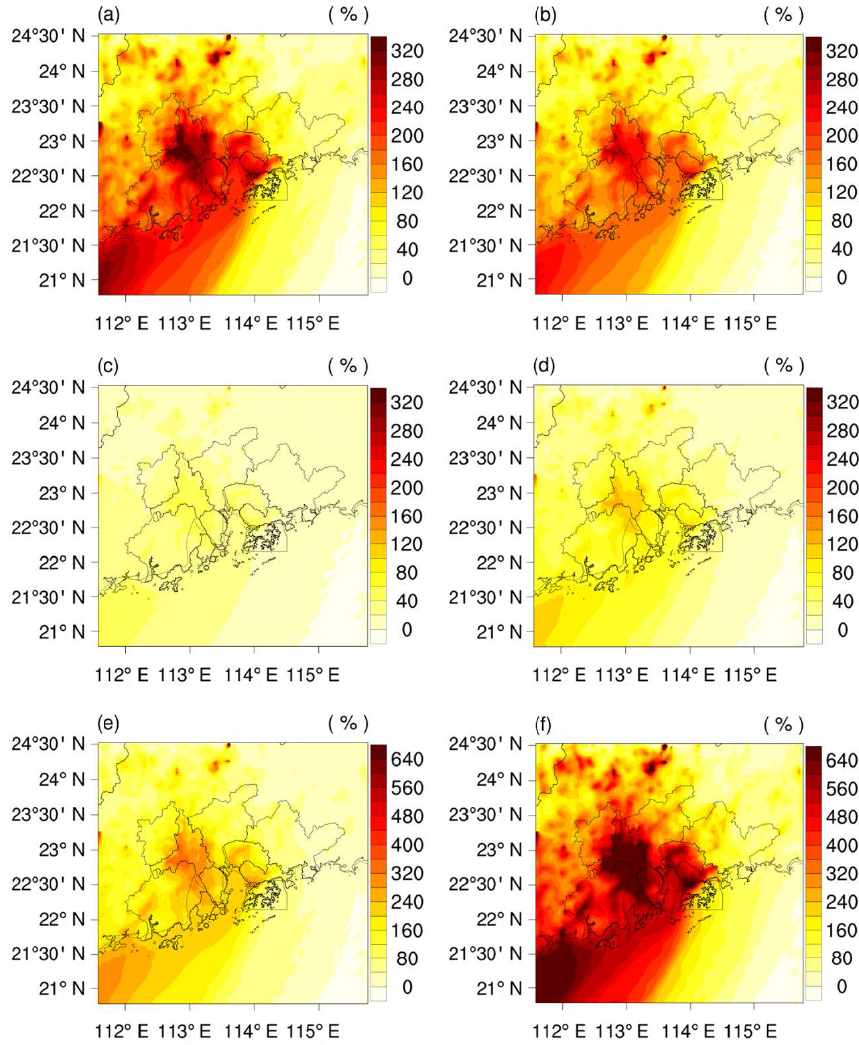
Figure 7. Relative difference of SOA between CASE runs and BASE: (a) CASE1, (b) CASE2, (c) CASE3, (d) CASE4, (e) CASE5, (f)